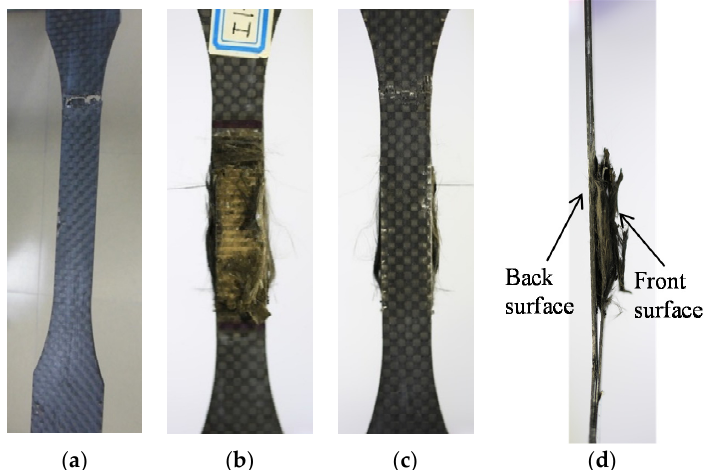
Figure 5. Failure modes of CFRP specimens obtained from tensile tests. ( a ) L (Lateral) failure mode; ( b ) D (edge Delamination) failure mode, front surface; ( c ) D (edge Delamination) failure mode, back surface; and ( d ) D (edge Delamination) failure mode, side view.